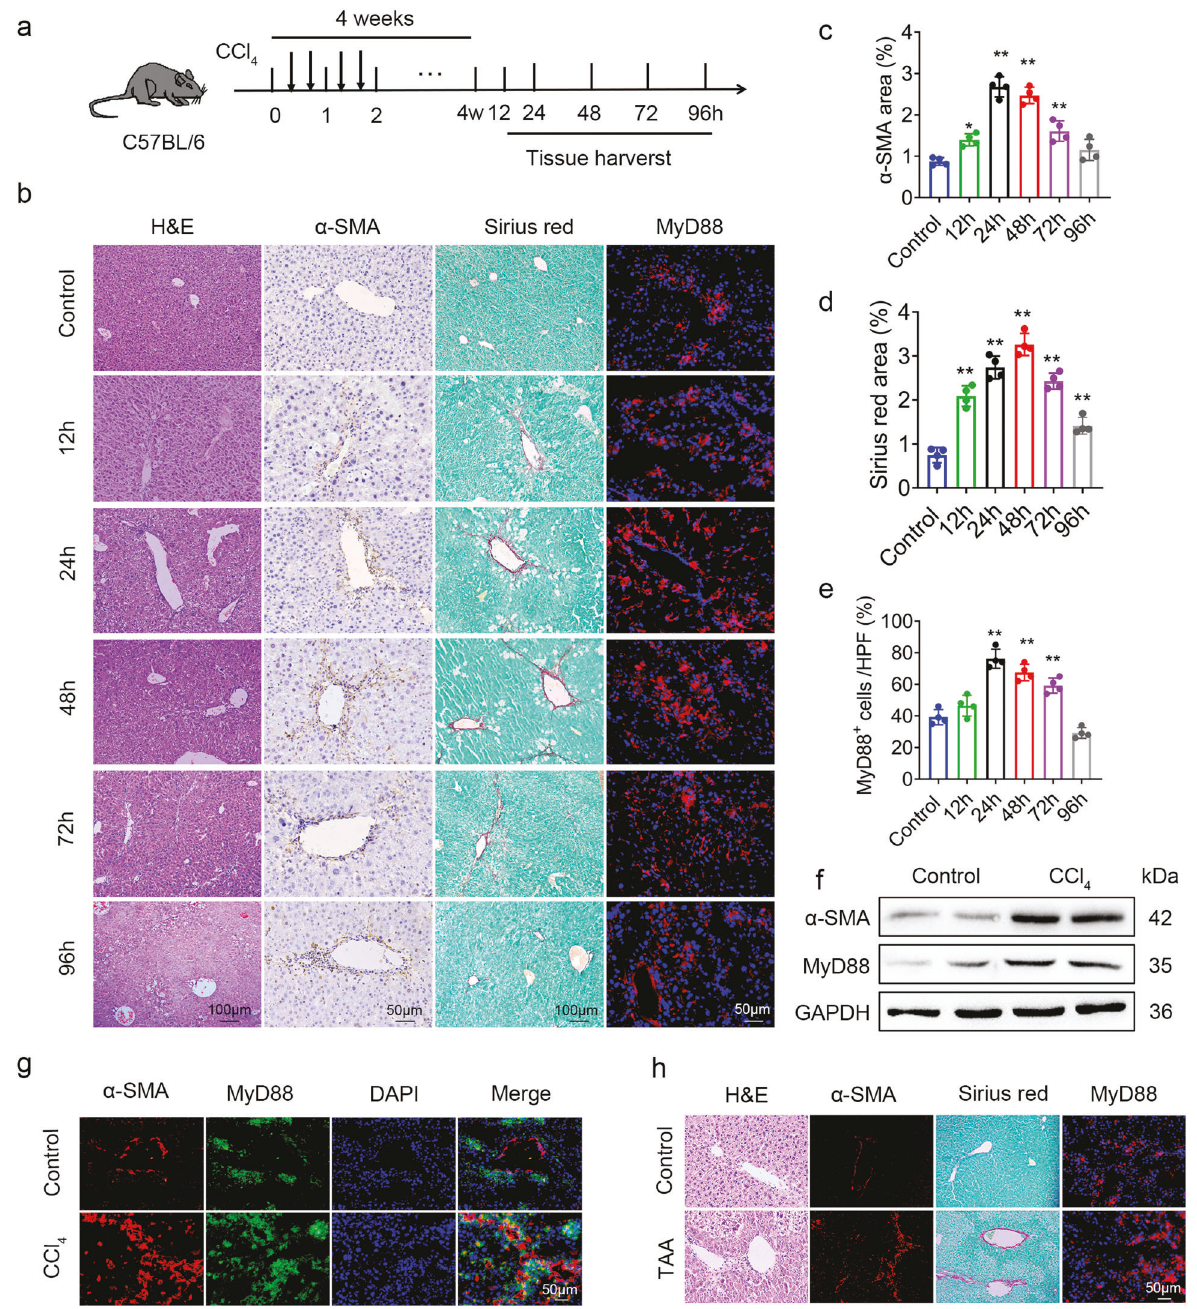
fi brosis. Data were representatives of at least three independent experiments. These charts show the average of the 4 -induced liver experimental results, with the error bar showing the standard error of mean. a Schematic illustration of CCl 4 -induced liver fi brosis. b Liver tissues were harvested at the indicated timepoints and stained for H&E, Sirius Red, anti- α -SMA and MyD88 antibodies. Scale bar, 50 or 100 μ m. c – e Statistical analysis of the α -SMA, Sirius red, and MyD88 staining in liver tissues. * p < 0.05 and ** p < 0.01. f The expression levels of α -SMA and MyD88 proteins in liver tissues were determined by Western blot analysis. g Representative double-staining of α -SMA and MyD88 in liver tissues. Scale bar, 50 μ m. h Sections of liver tissues were stained for H&E, Sirius red, α -SMA and MyD88 in C57BL/6 mice treated with TAA. Scale bar, 50 μ